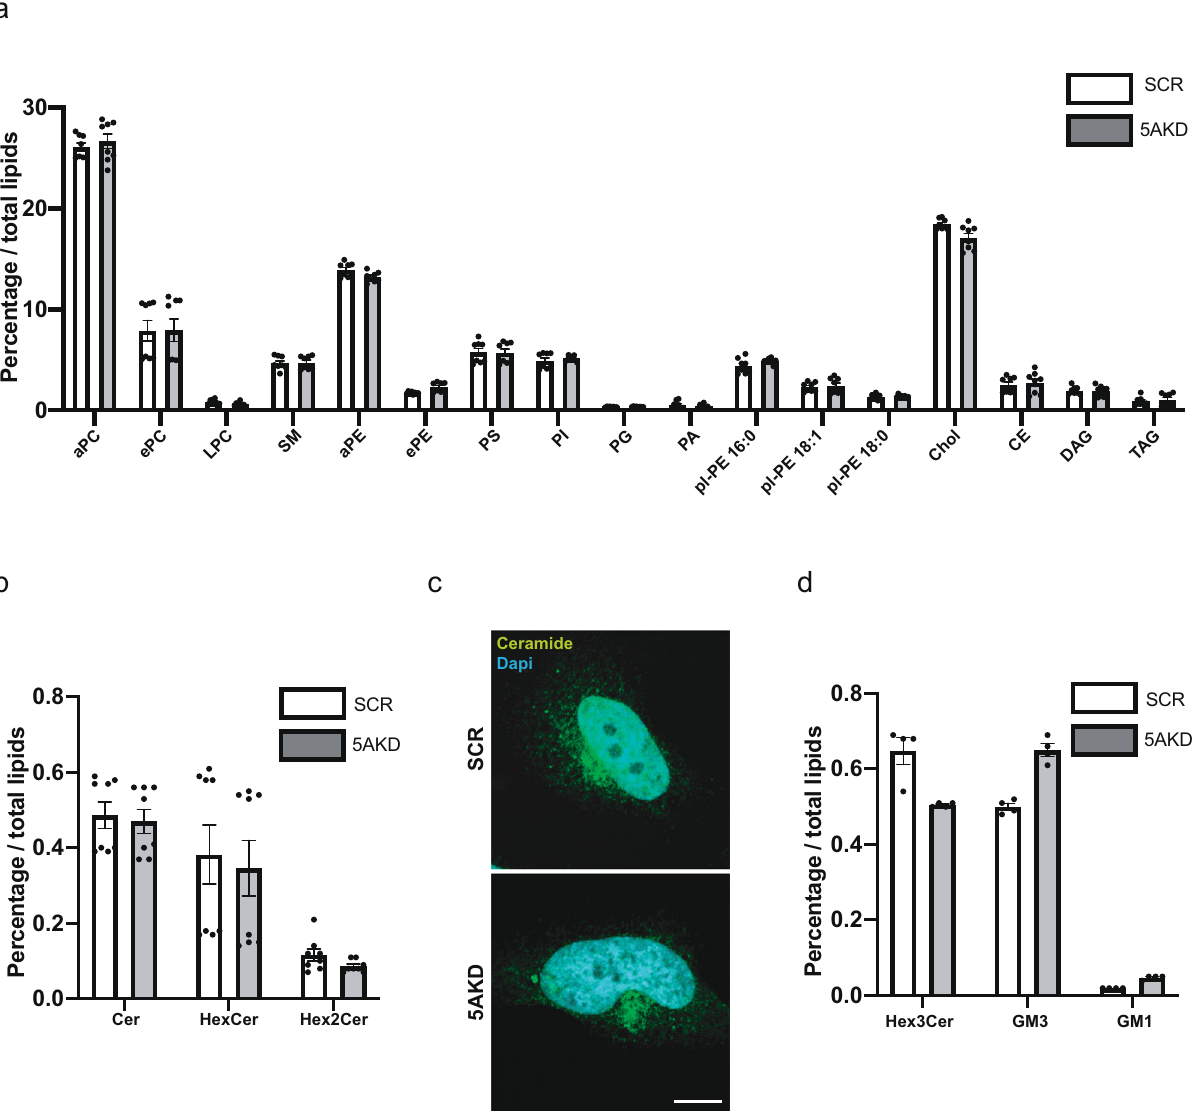
Fig. 2 Total cellular lipid levels in absence of INPP5A. a , b , d Lipidomic analyses. SCR, control (SCR), 5AKD, INPP5A-depleted HeLa cells. Ceramide (Cer), cholesterol (Chol), cholesteryl ester (CE), diacylglycerol (DAG), dihexosylceramide (Hex2Cer), ganglioside GM1 (GM1), ganglioside GM3 (GM3), globoside Gb3 /trihexosylceramide, (Hex3Cer), hexosylceramide (HexCer), lyso-PC (LPC), phosphatidic acid (PA), phosphatidylcholine (PC), phosphatidylethanolamine (PE), phosphatidylglycerol (PG), phosphatidyinositol (PI), phosphatidylserine (PS), plasmalogen (plasmenyl) ethanolamine (pl- PE), sphingomyelin (SM), triacylglycerol (TAG). a = acyl-linked glycerophospholipids, e = ether-linked (plasmanyl) or containing one odd-chain fatty acyl. Two-sided t -test corrected for multiple comparisons using the Holm-Sidak method: aPC: p = 0.49, t = 0.69, df = 14. ePC: p = 0.98, t = 0.02, df = 14. LPC: p = 0.076, t = 1.91, df = 14. SM: p = 0.90, t = 0.1252, df = 14.aPE: p = 0.033, t = 2.35, df = 14. ePE: p = 0.005, t = 3.239, df = 14 aPS: p = 0.93, t = 0.08, df = 14. pl-PE 16:0: p = 0.077, t = 1.90, df = 14. pl-PE 18:1: p = 0.700, t = 2.29, df = 14. pl-PE 18:0: p = 0.49, t = 0.6964, df = 14. Chol: p = 0.013, t = 2.814, df = 14. CE: p = 0.644, t = 0.47, df = 14. DAG: p = 0.92, t = 0.1001, df = 14. TAG: p = 0.56, t = 0.58, df = 14. Cer: p = 0.734, t = 0.346, df = 14. HexCer: p = 0.74, t = 0.33 df = 14. Hex2Cer: p = 0.093, t = 1.79, df = 14. Hex3Cer: p = 0.007, t = 3.955, df = 6. GM3: p = 0.0002, t = 7.83, df = 6. GM1: p